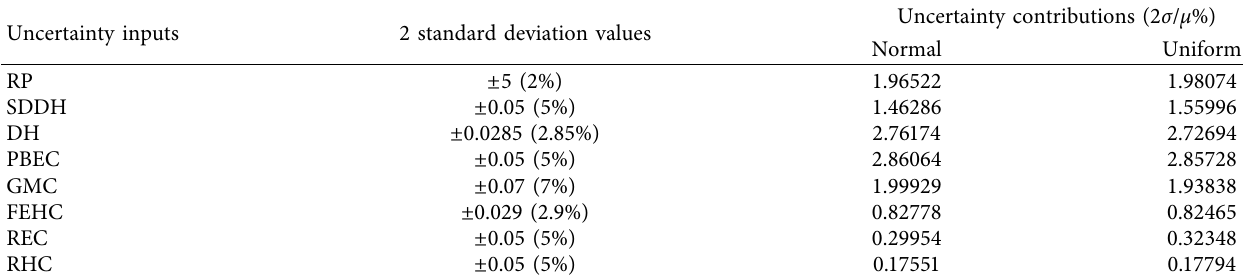
Figure 18: The maximum fuel temperature due to the inputs with uniform and normal distribution. (a) Inputs with uniform distribution. (b) Inputs with normal distribution. Table 8: Contributions of each input to uncertainty of the maximum fuel